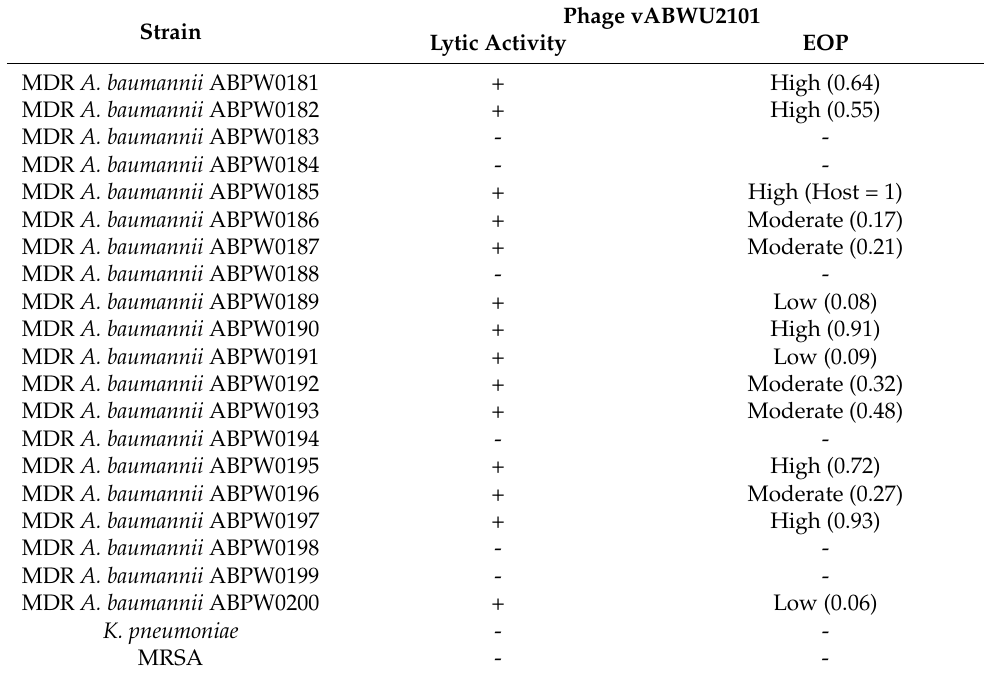
Table 1. Host range infection and EOP of phage